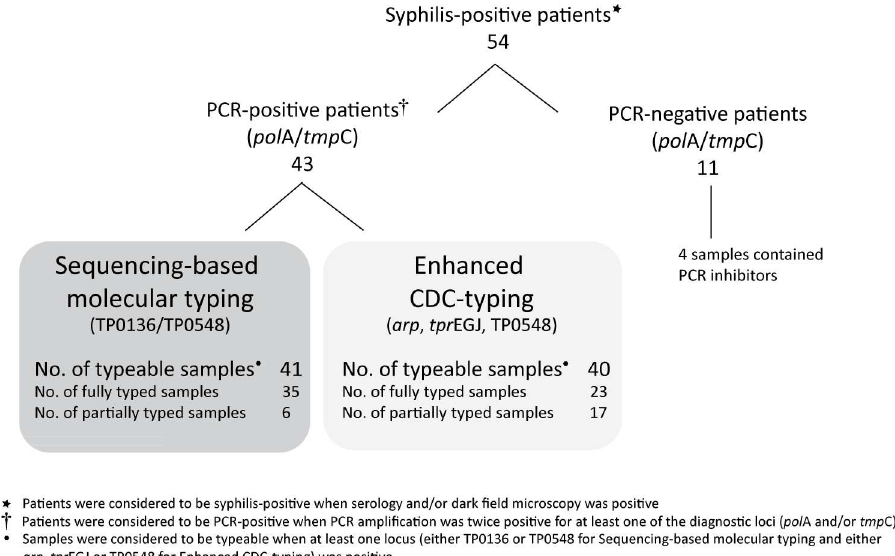
Fig 1. Flow chart of 54 patients included in the